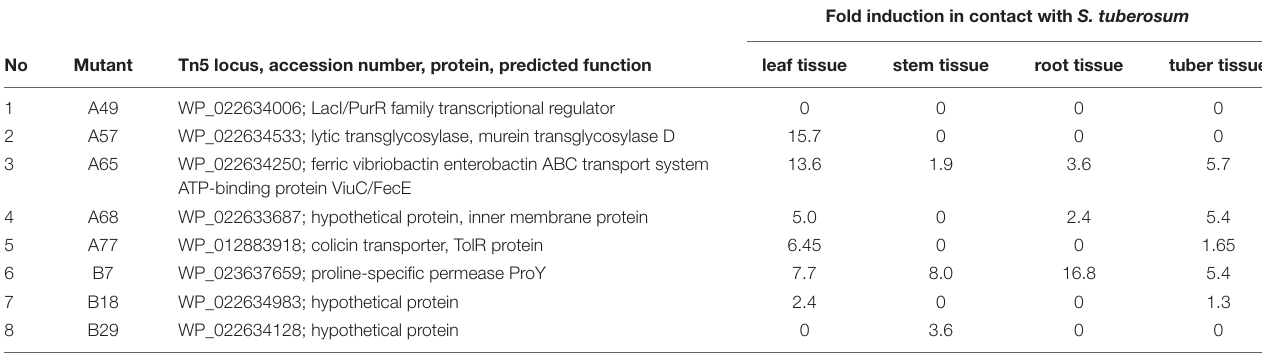
TABLE 3 | Genetic loci of D. solani strain IPO2222 Tn5 mutants regulated by the presence of plant tissue of Solanum tuberosum .